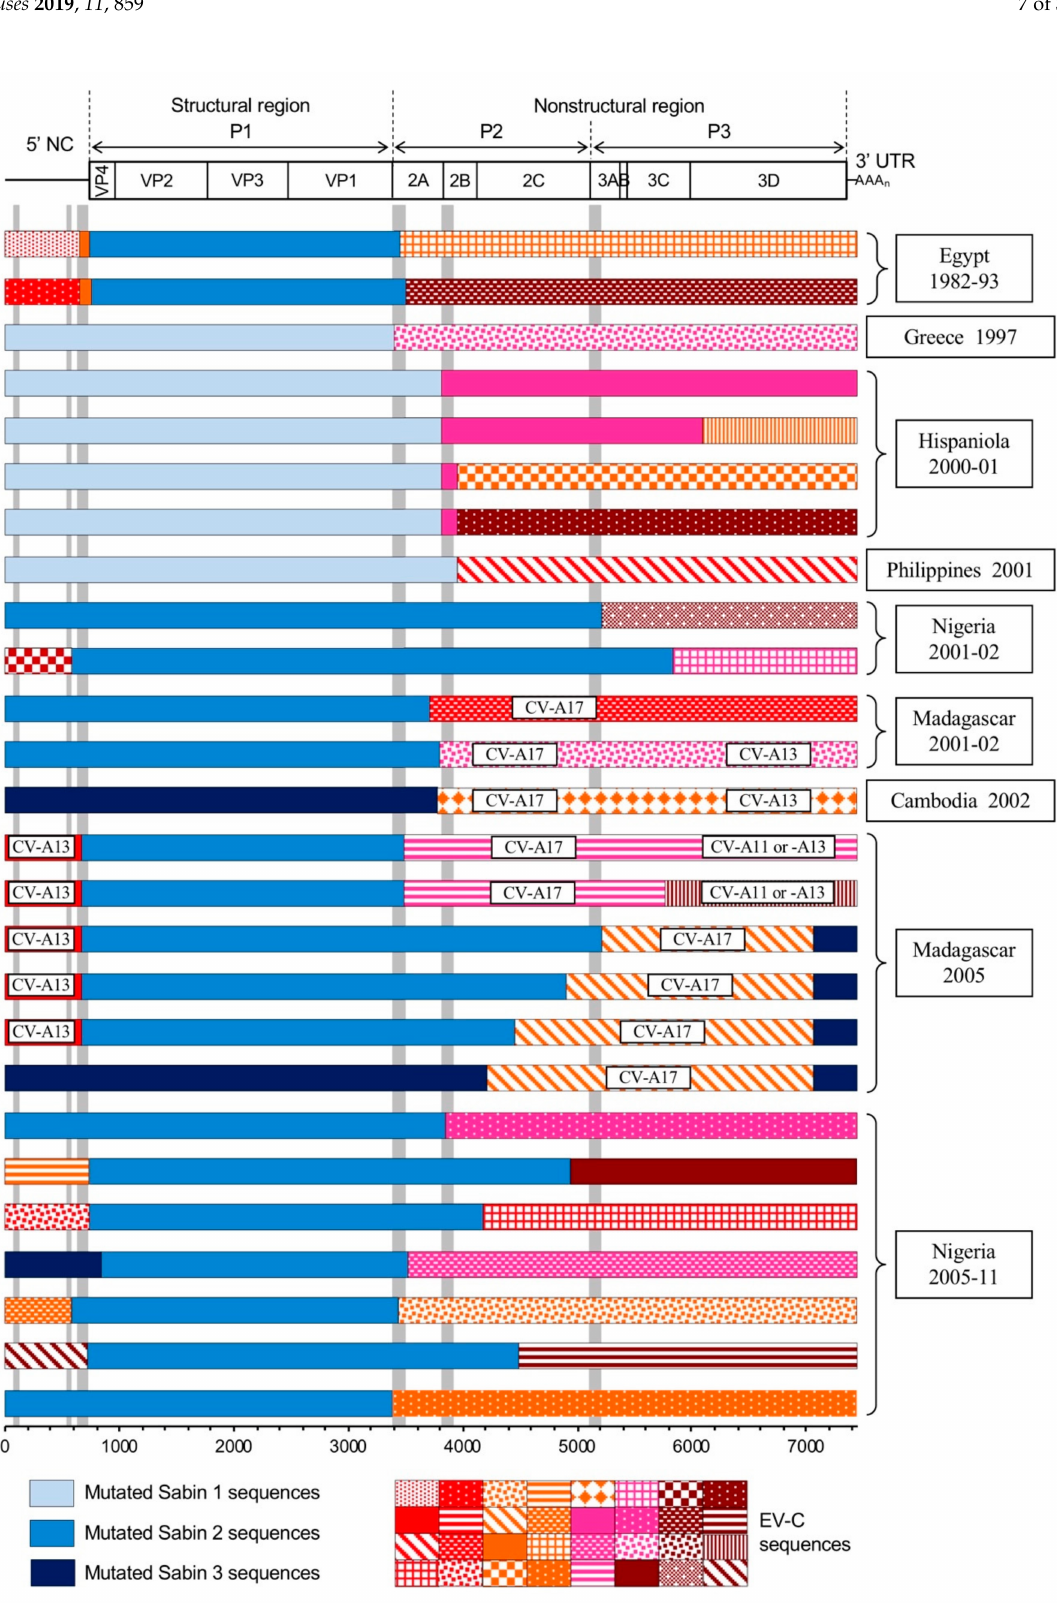
Figure 3. Genomic structures of all recombinant circulating vaccine-derived poliovirus lineages characterized so far. A schematic view of the genetic organization of the poliovirus genomes is given in the upper panel (see also Figure 1). The presence of vaccine-derived sequences is indicated (mutated Sabin1, 2, of3sequences)aswellasthenon-vaccinesequencesderivedfromotherspeciesCenteroviruses (EV-Cs). Colors and patterns di ff erentiate EV-C sequences that di ff ered significantly from each other. Non-vaccine sequences showing similarity with those of co-circulating coxsackieviruses A (CV-A11, -A13, -A17) are indicated. Data are modified from [73] (Egypt), [67] (Greece), [68] (Hispaniola), [69] (Philippines), [71,72] (Nigeria), [65,66,70,76] (Madagascar), [120] (Cambodia). The location of the six recombinant hotspots identified by experimental studies of genetic exchanges between poliovirus and enteroviruses is indicated by grey rectangles [77,121,122] (see further in the